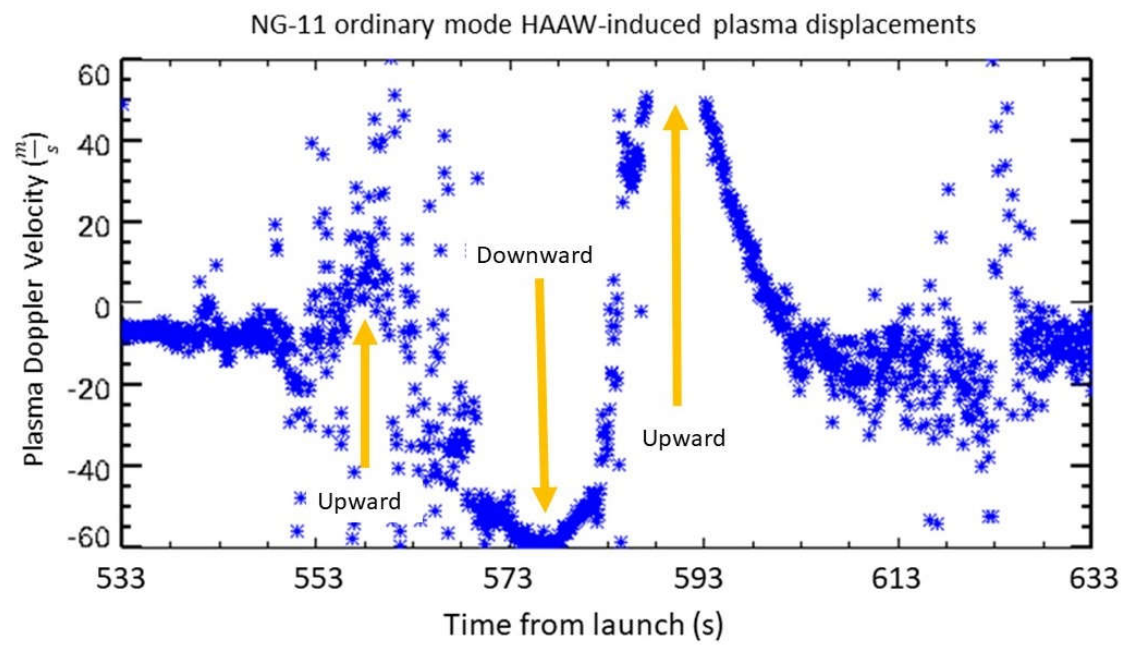
Figure 1. Doppler velocity plot of 4165 kHz fixed frequency O-mode observations beginning at 20:55 UTC. Upward and downward plasma displacement peaks are identified. The gap in the data during the second upward plasma displacement peak is a result of the VIPIR not transmitting at that time.